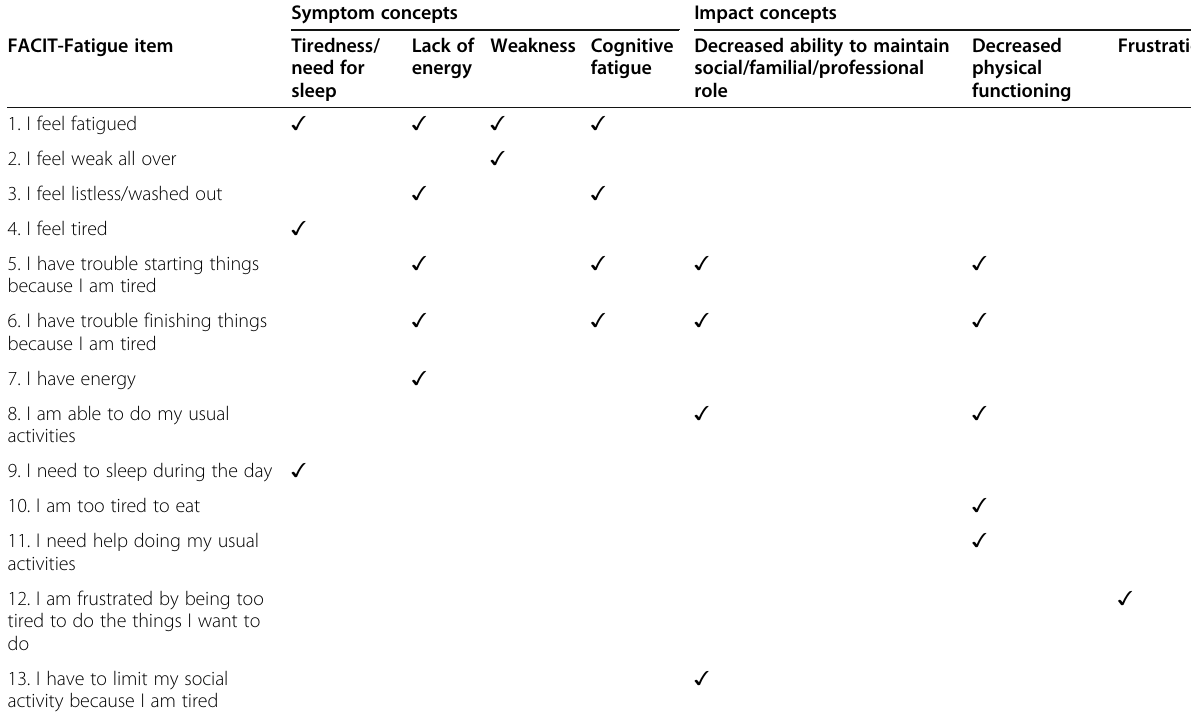
Table 2 Mapping FACIT-Fatigue items to fatigue-related sub-components identified during concept